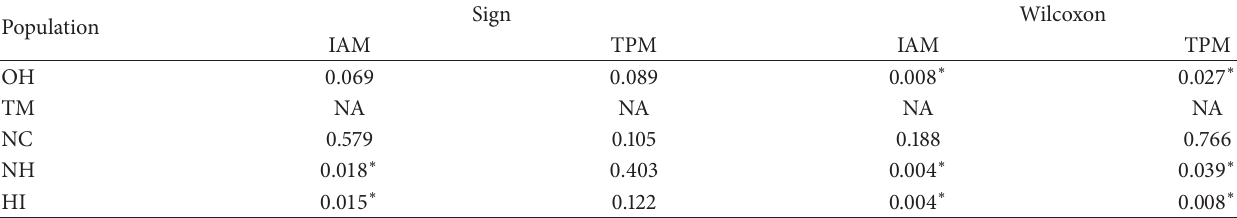
Table 4: Probability of a bottleneck estimated using the program